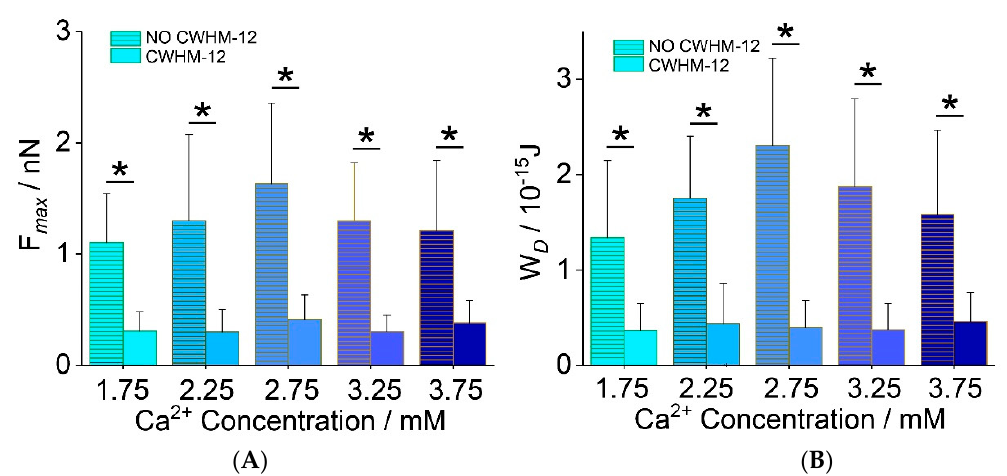
Figure 6. The effects of extracellular Ca 2+ concentration on human chondrocytes myosin and integrin β 1 fluorescence density. ( A ) A representative integrin β 1 fluorescence image taken at 1.75 mM Ca 2+ concentration. Scale bar 50 µ m; ( B ) As Ca 2+ concentration increases, fluorescence density of integrin β 1 increased by 20% from 1.75 mM to 2.75 mM, and then decreased from the 2.75 mM group to 3.75 mM. ( C ) A representative myosin fluorescence image taken at 1.75 mM Ca 2+ concentration. Scale bar 50 µ m; ( D ) As Ca 2+ concentration increases, fluorescence density of myosin increased by 50% from 1.75 mM to 2.75 mM and then decreased by 20% from 2.75 mM to 3.75 mM. 60 cells are measured and analyzed in each group. Letters (a, b, c) above the bars in ( B , D ) correspond to distributions that are (letters different) or are not significantly different (letter shared) at the p < 0.01 level.